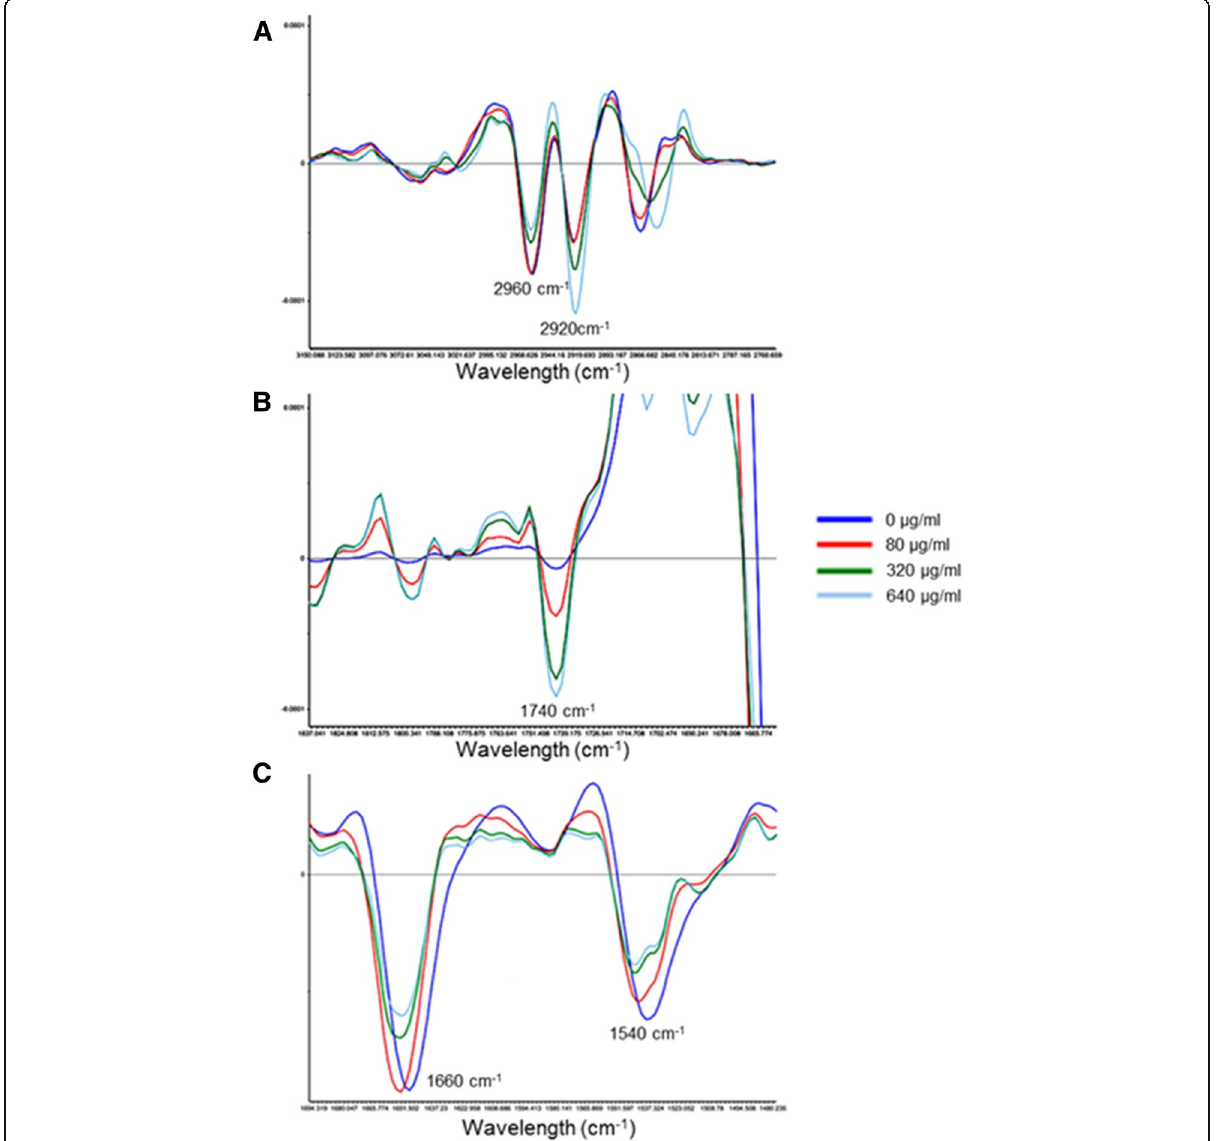
Fig. 3 ATR-FTIR second derivative spectra of the erythrocytes incubated with different CMNv concentrations (0,80, 320 and 640 μ g/mL). ( a ) Second derivative of skeletal carbons of lipids, primary carbon (2960 cm − 1 ) and secondary carbon (2920 cm − 1 ) bands. b Second derivative of aldehyde bond band (1740 cm − 1 ) related to secondary products of lipid peroxidation. c Second derivative of the amide bonds region, amide I (1660 cm − 1 ) and amide II (1540 cm − 1 ) that are the main bands related to protein